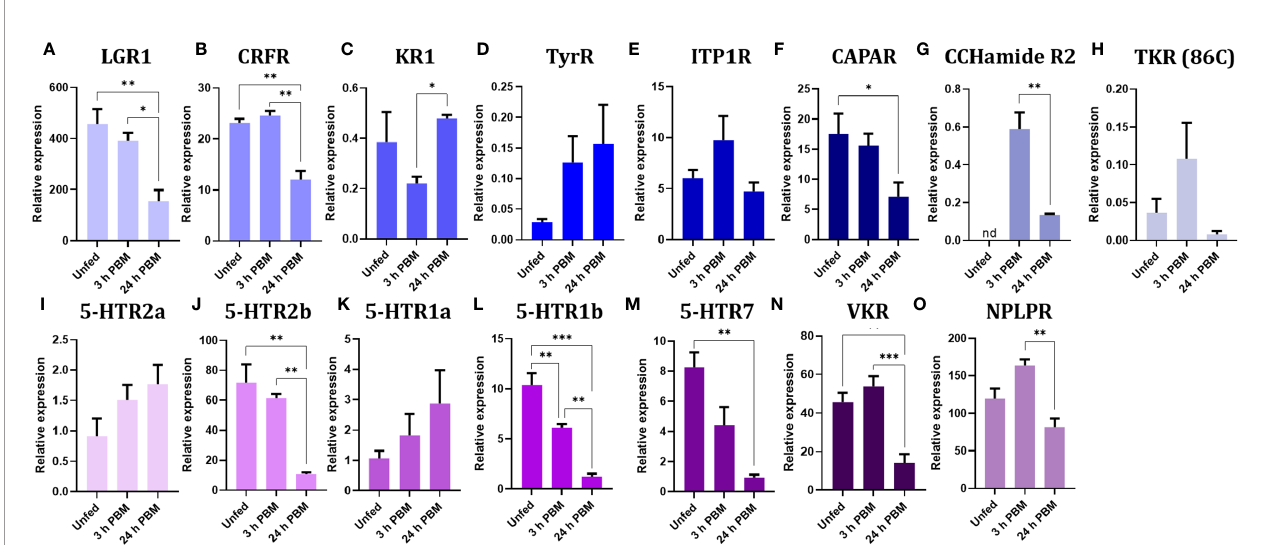
FIGURE 7 | Veri fi cation of transcriptome analysis by RT-qPCR for G protein-coupled receptors (GPCRs) and receptor tyrosine kinases (RTK) in Malpighian tubules of unfed and fed insects. Fifth instar insects were dissected at 15 days post-ecdysis as representative days of the unfed condition (unfed). One group of insects was allowed to gorge, and mRNA expression assayed at 3 and 24 h post blood meal (h PBM). The expression of transcripts to thirteen GPCRs (A – M) and two RTKs (N, O) was quanti fi ed using RT-qPCR and the D Ct method. The y axis represents the relative expression by 1000 copies of reference genes, obtained via geometric averaging using Rp49 and b -actin. The results are shown as mean ± SEM (n=4-5). Statistical analysis was performed using a one-way ANOVA and Tukey ’ s test for post-hoc analysis; p-values are listed on the graph (****p < 0.0001; ***p < 0.001; **p < 0.01; *p < 0.05; nd, not detected). Graphs and statistical tests were performed using GraphPad Prism 7. LGR1, GPA2/GPB2 receptor; CRFR, corticotropin-releasing factor-related diuretic hormone receptor 2; KR1, kinin receptor 1; TyrR, tyramine receptor; ITP1R, ion transport peptide 1 receptor; CAPAR, CAPA receptor 1 isoform A; CCHamideR2, CCH amide2 receptor; TKR (86C),